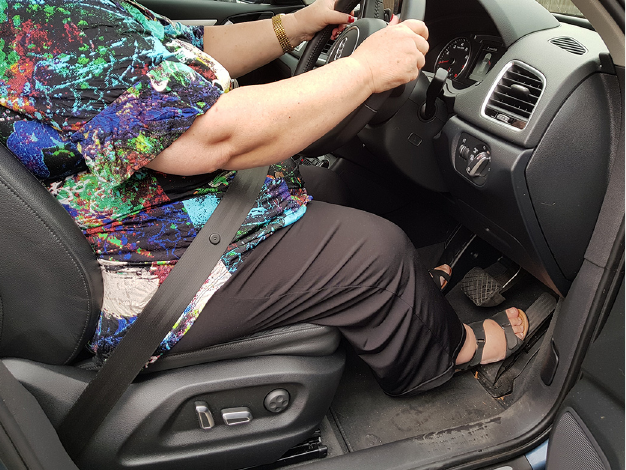
Figure 3. Patient in driving seat day after anterior THA, with hip fl exion (70 ° ), knee fl exion (45 ° ) and ankle plantar fl exion (30 ° ) while accelerating.